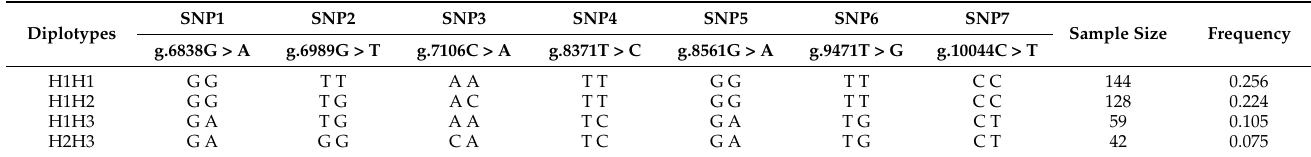
Table 3. Diplotypes of MYF5 gene and the frequencies in GSTS